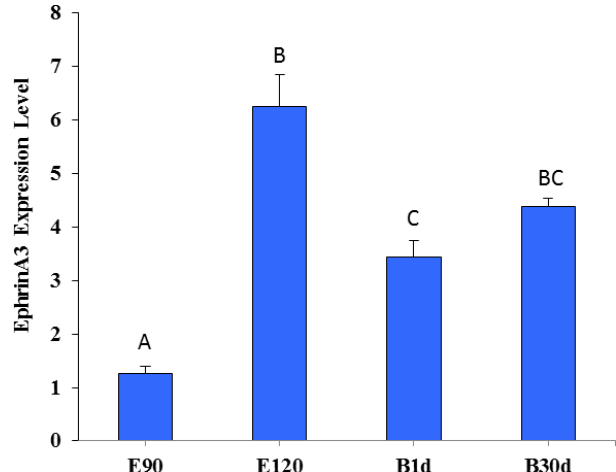
Figure 5. The relative expression level of Ephrin A3 in the skin of fine-wool sheep at the different developmental